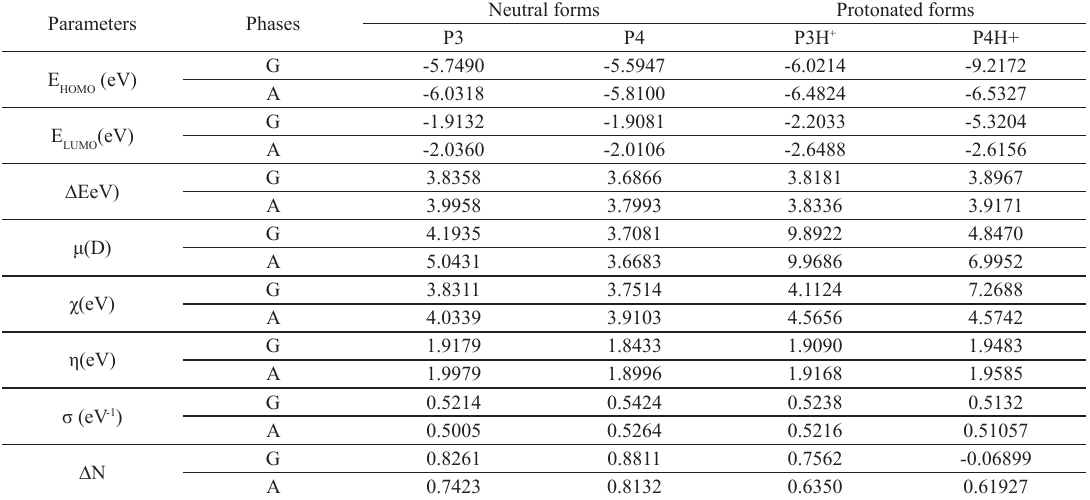
Table 7. Quantum chemical parameters calculated at the B3LYP/6-31(d, p) level for the neutral and protonated forms of P3 and P4 compounds in gaseous and aqueous phases. Parameters